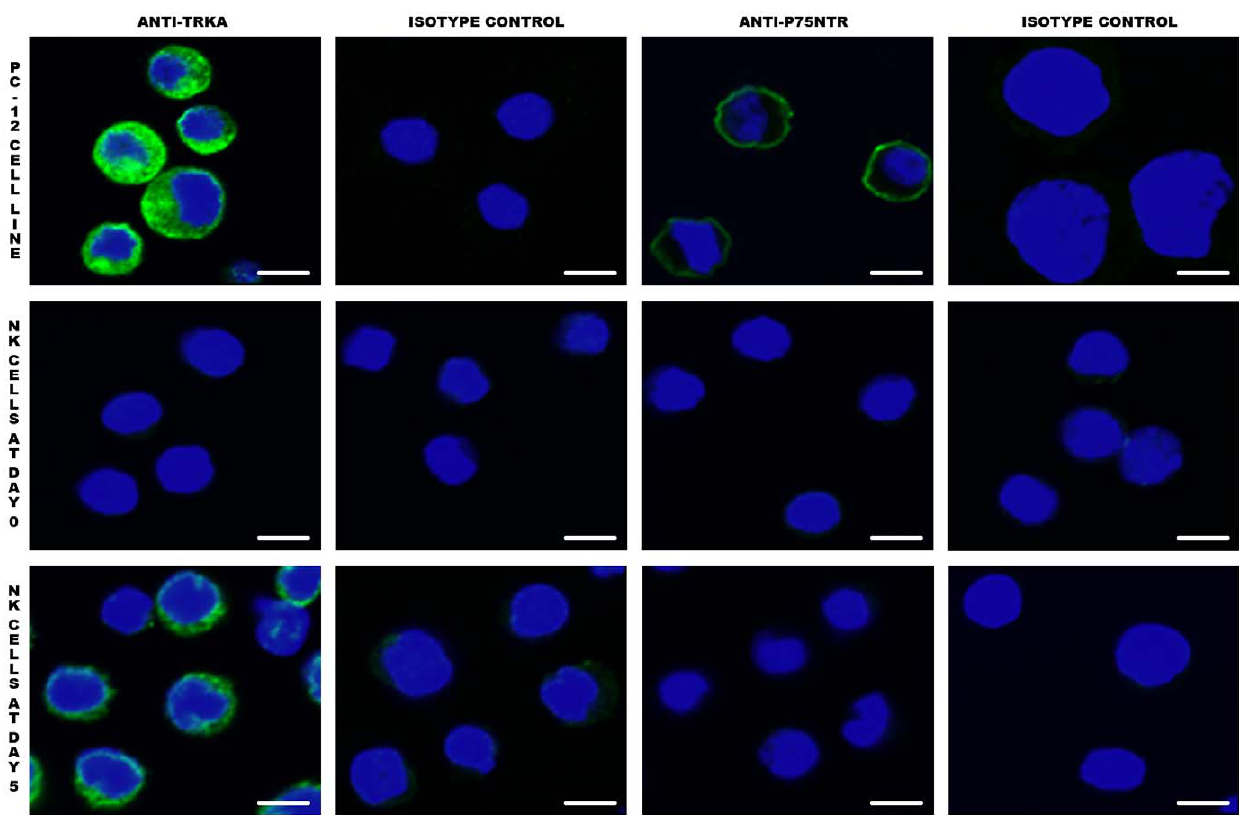
Figure 3. TrkA expression on NK cells as assessed by confocal microscopy. Cells were prepared for confocal microscopy as described in Materials and Methods. TrkA, but not p75 NTR , is expressed by activated NK cells (green staining). On fresh NK cells (NK Day 0), the expression level of TrkA is probably too low to be evidenced by confocal microscopy, in contrast to flow cytometry. PC12 is a rat pheochromocytoma cell line that serves as positive control, as it expresses both TrkA and p75 NTR at high levels. The bar corresponds to 3 m m. Data shown are from one representative experiment out of three performed.